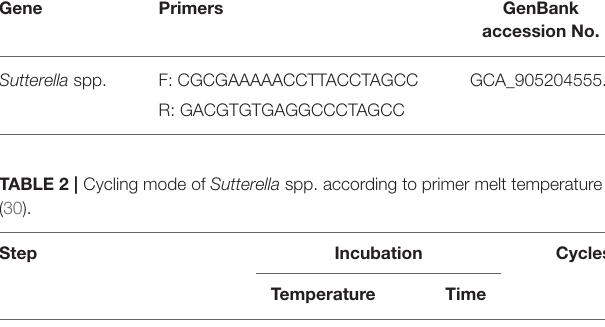
TABLE 3 | Presence of Sutterella spp. with corresponding Cq values in broiler cecal content, liver, and breast. Live poultry accession No.